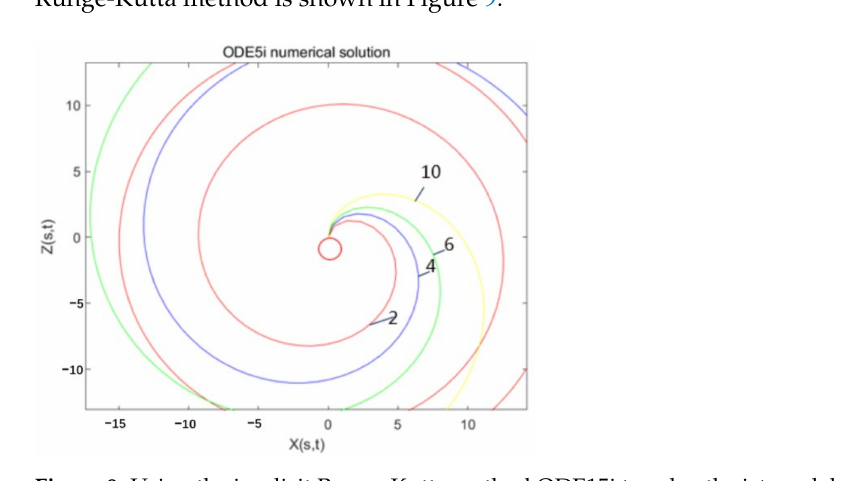
Figure 9. Using the implicit Runge-Kutta method ODE15i to solve the jet model. The jet trajectory diagram when We = 10, Rb = 2, 4, 6, 10 when the iteration interval is